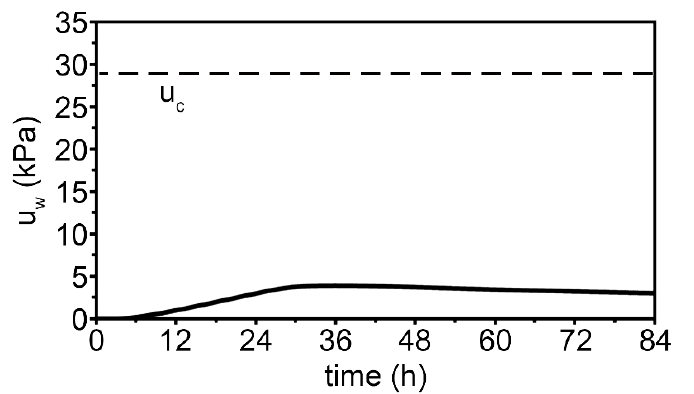
Figure 17. Evolution of the change in pore water pressure, u w , with time due to the rainfall of 10 April 2005, with indication of the critical threshold, u c , at the depth of 1.40 m.